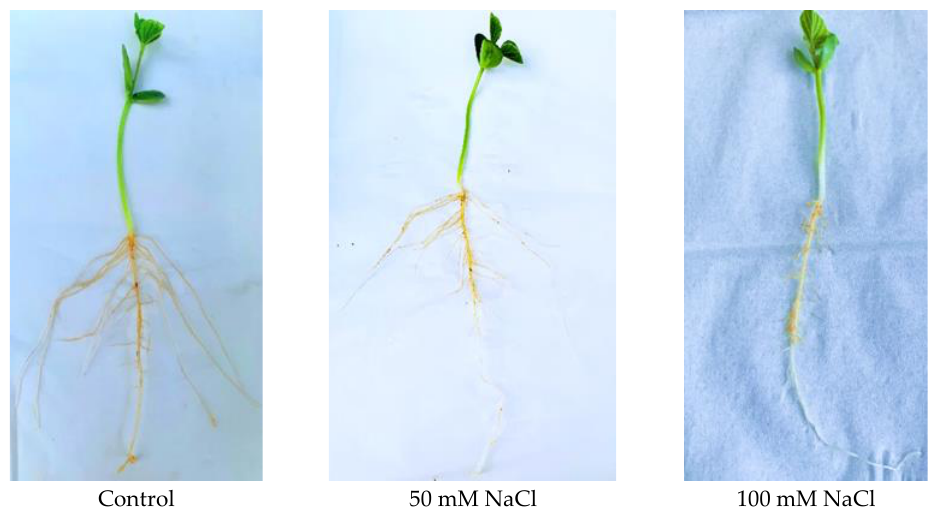
Figure 1. Phenotypes of salt-germinated 7-day-old seedlings of the cultivated soybean genotype C08 under 50 mM and 100 mM NaCl. Treated plants showed an overall stunted growth with decreased root and shoot growth.